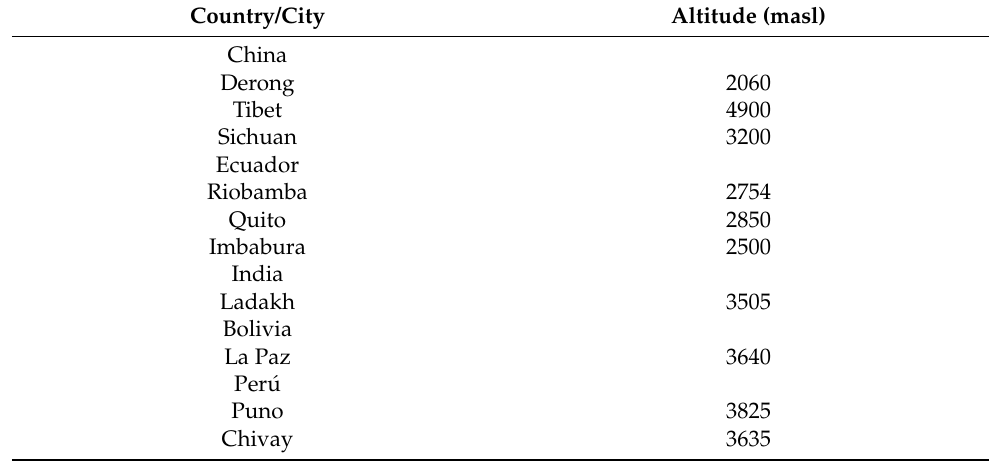
Table 4. Altitude level of cities and countries that have investigated metabolic syndrome in